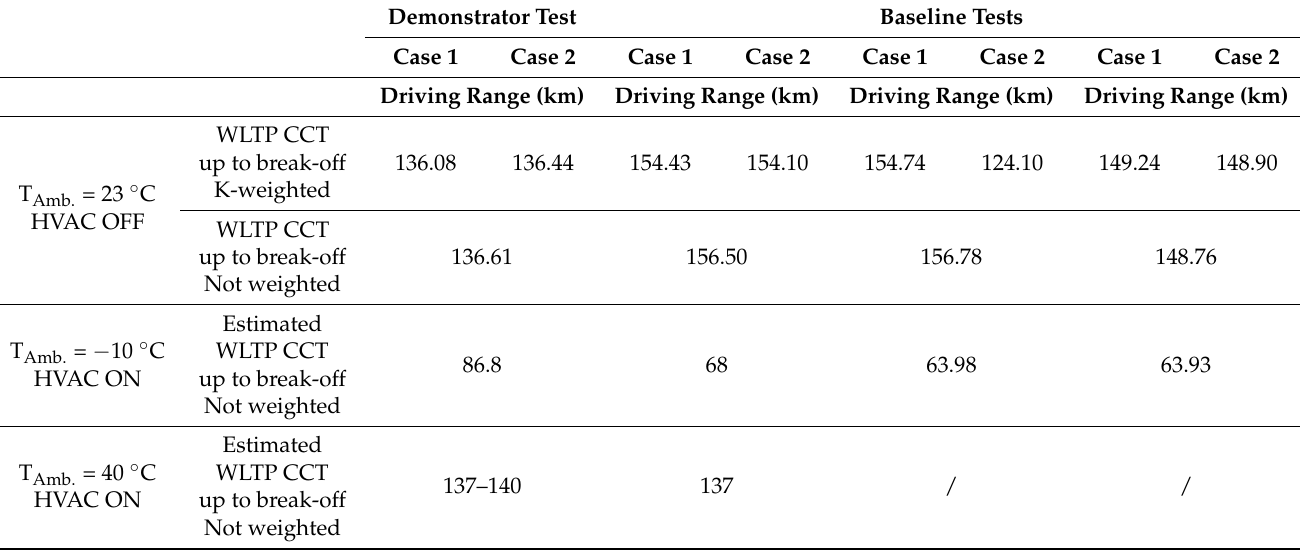
Table 8. Driving range test results for the WLTP CCT procedure at the different ambient temperatures. Demonstrator Test Baseline Tests Case 1 Case 2 Case 1 Case 2 Case 1 Case